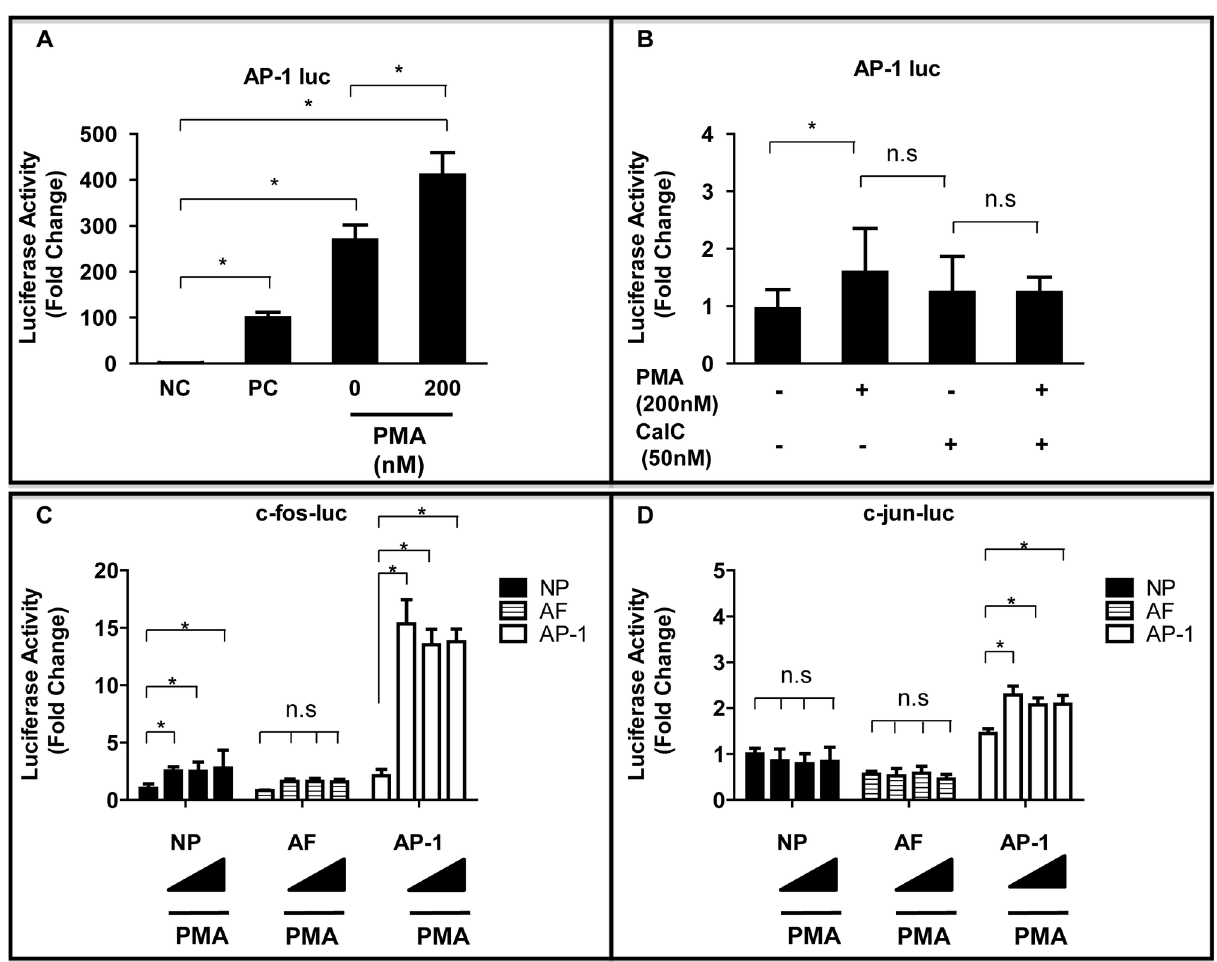
Figure 1. Effect of the PKC activator PMA on AP-1, c-fos or c-jun transcription in IVD cells. ( A ) AP-1 was transfected with the pGL4.74 vector into NP cells, and the cells were stimulated with PMA (200 nM) for 24 h. NC = negative control, (= 1.0 fold); PC = positive control. ( B ) Effect of activation or inhibition of the PKC pathway on AP-1 promoter activity in NP cells. ( C , D ) c-fos ( C ) or c- jun ( D ) was transfected with the pGL4.74 vector into NP cells, AF cells, and AP-1 reporter stable cells, and the cells were stimulated with PMA (10, 100 or 200 nM) for 24 h. * P < 0.05 indicates significant differences between groups. Error bars represent the standard deviation (SD). n.s. = not